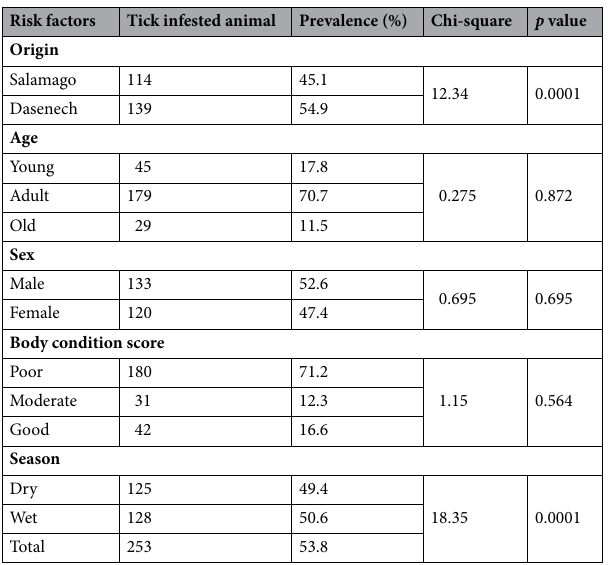
Table 3. Prevalence of ixodid tick and its associated risk factors.